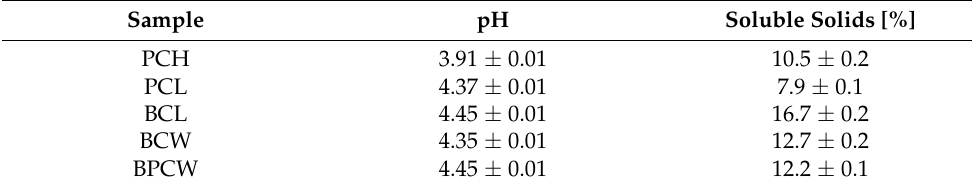
Table 1. pH and total soluble solids of